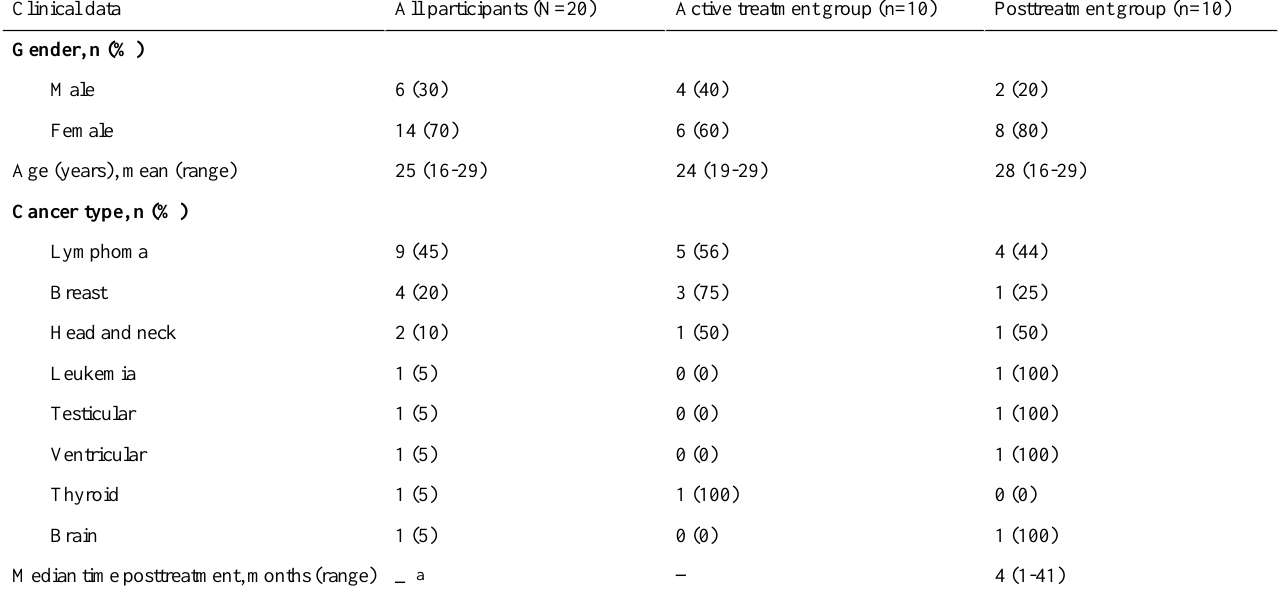
Table 1. Demographic and clinical information of participants